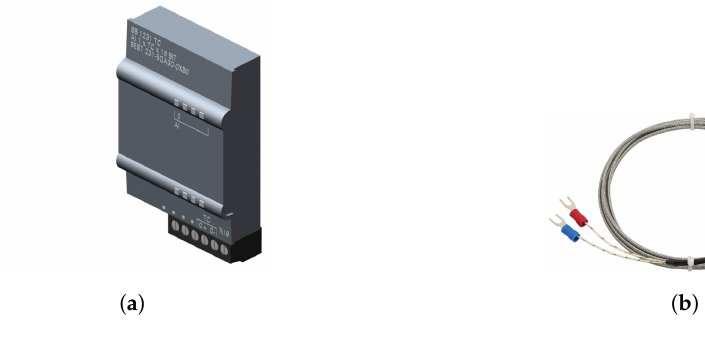
Figure 4. General view of the ( a ) SB1231TC module and ( b ) TJ400